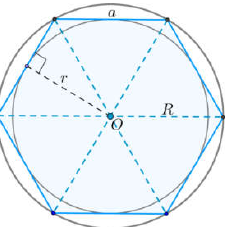
Figure 8 . Main dimensions of hexagonal, where r = the inscribed circle radius.